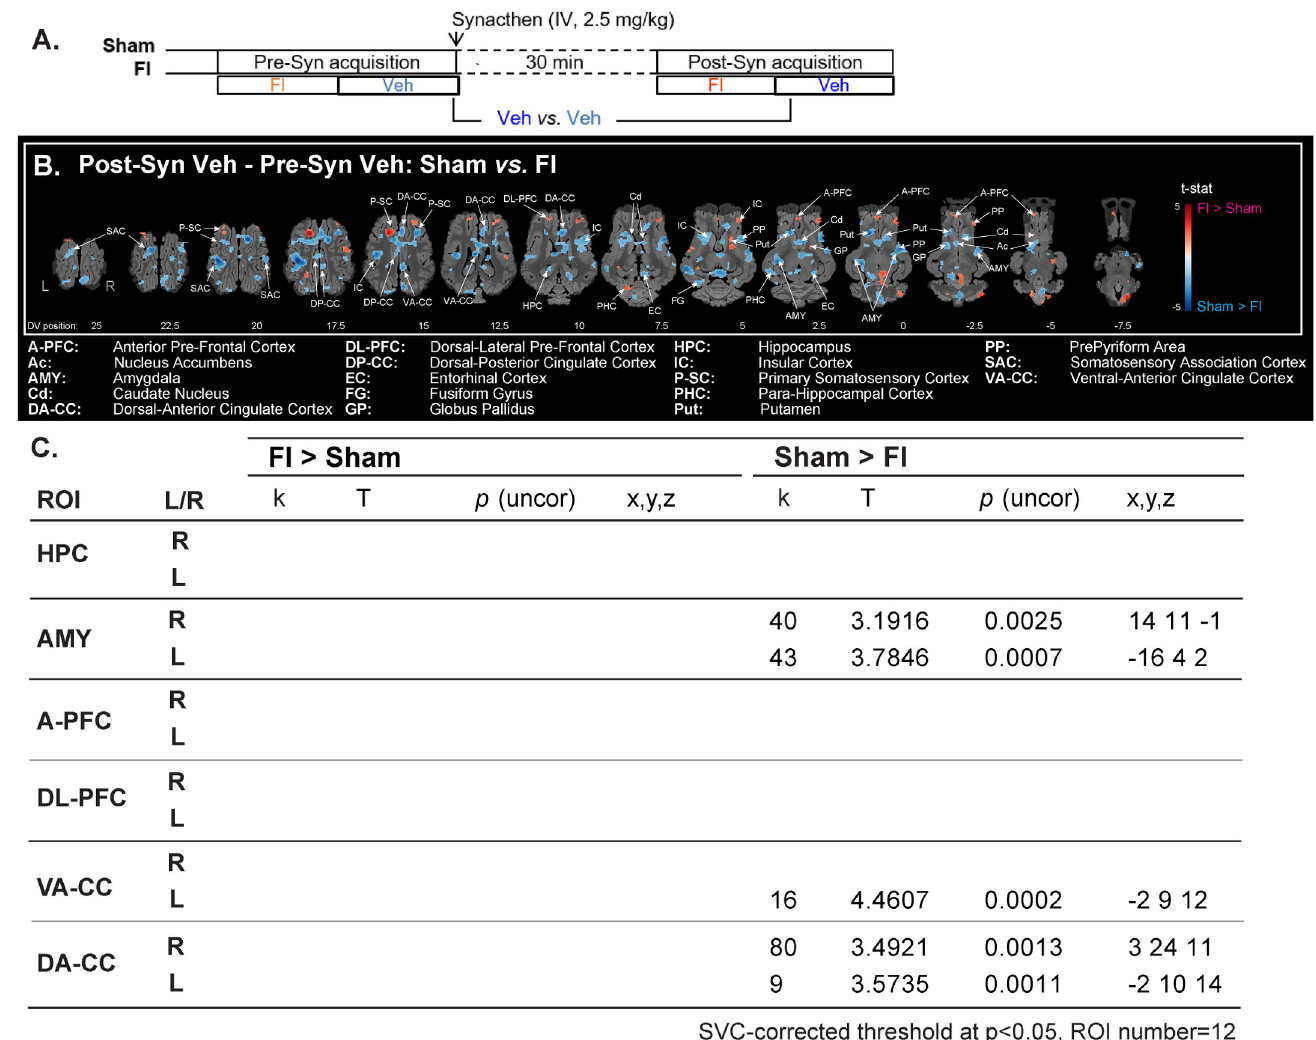
(Sham, n = 10) animals. FI: Olfactory stimulation with the food ingredient, Veh: Neutral stimulation with the vehicle. (B) Horizontal maps of brain BOLD increased responses to the injection in both groups. p-value threshold = 0.05, k > 20, DV: Dorsal-ventral position related to the posterior commissure (in mm). The part of the frontal cortices that was not covered with the average BOLD-based statistical maps is superimposed in dark grey on the anatomical maps. (C) SVC-based statistics: Related regions of interest (ROIs) with uncorrected p-value that reached the criteria of p < 0.05 after Bonferroni